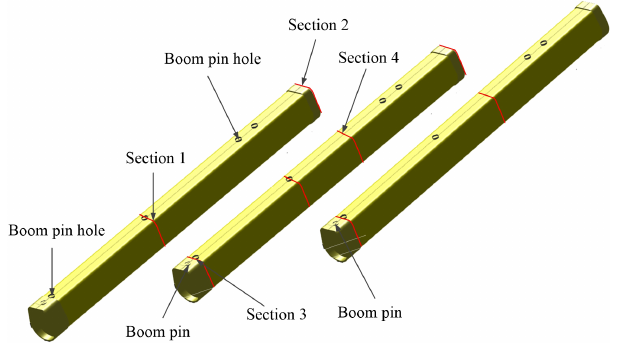
Figure 5. Boom section